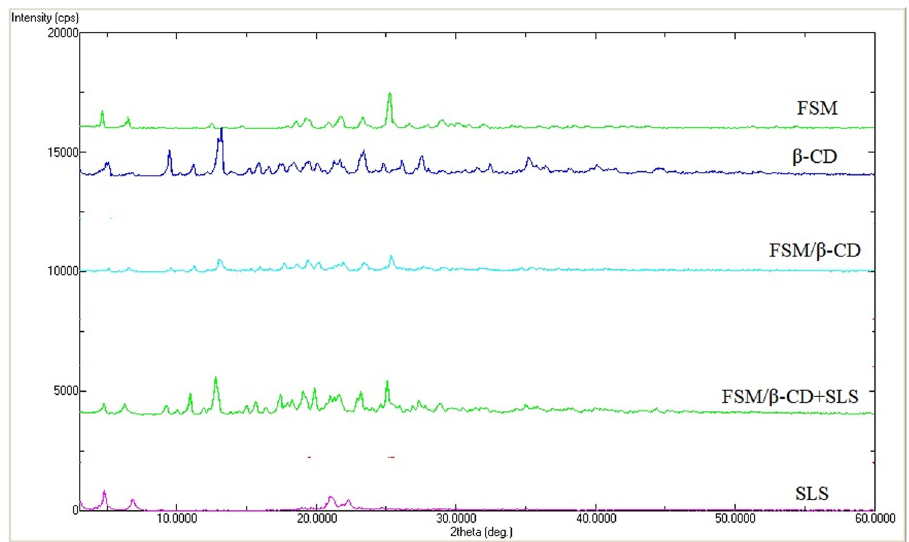
Figure 4: Comparative PXRD pattern of